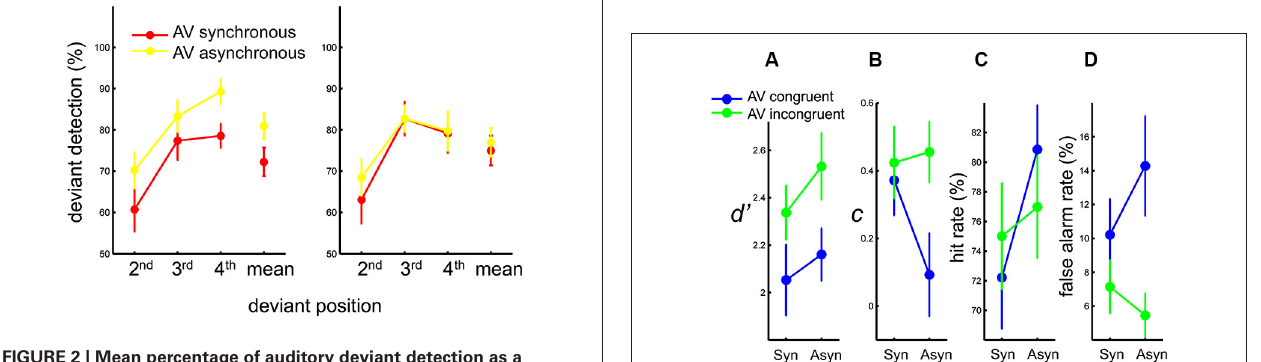
FIGURE 2 | Mean percentage of auditory deviant detection as a function of the deviant position, for each AV congruency and AV synchrony condition . The mean across deviant positions for each condition is also plotted in the respective graph. Error bars represent standard error of the means.